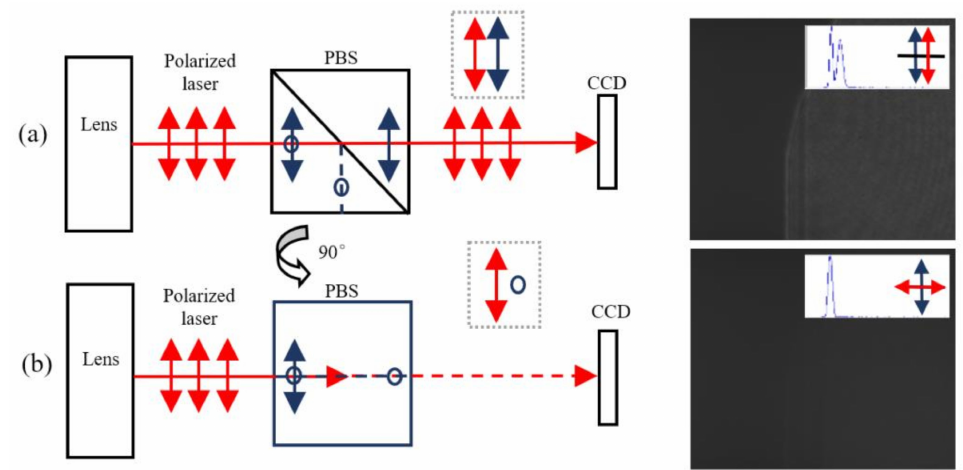
Figure 6. Polarization direction adjustment. ( a ) The PBS polarization direction is parallel with the laser light ( b ) The PBS polarization direction is perpendicular to the laser light.